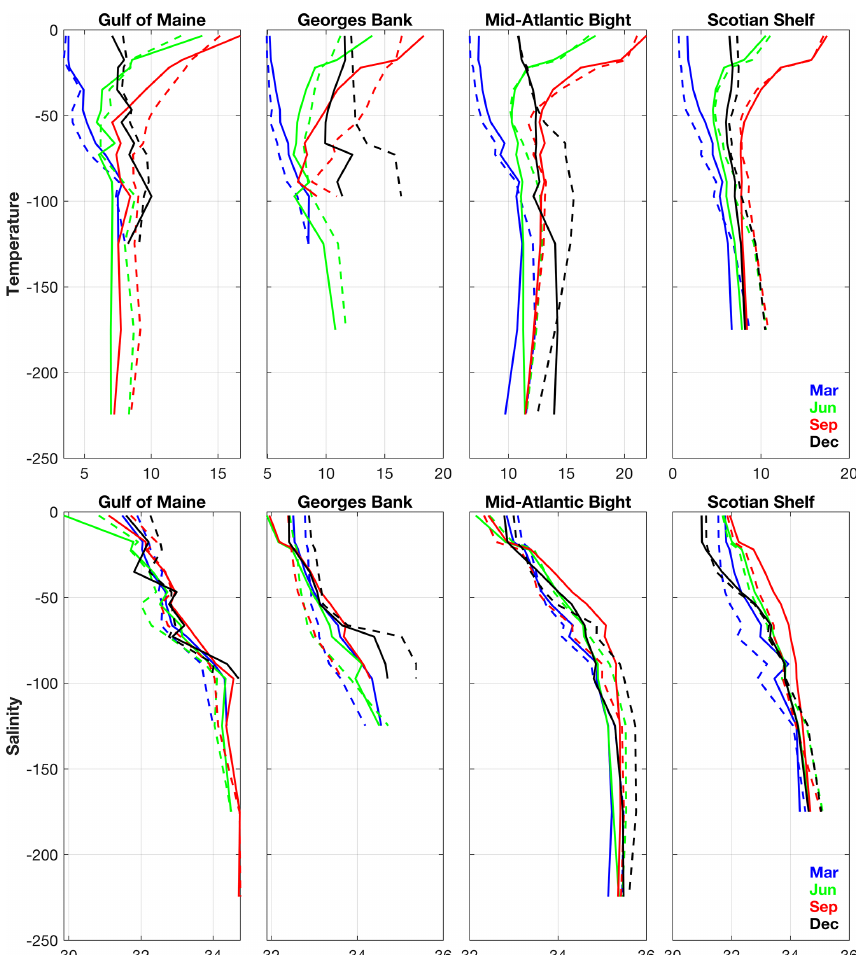
Figure 11. Vertical profiles of temperature and salinity, binned every 10m for the first 100m, then binned every 50m below 100m, for 4 representative months, for the upper 250m. Solid lines are the model profiles; dashed lines are the observation product profiles. Top: temperature. Bottom: